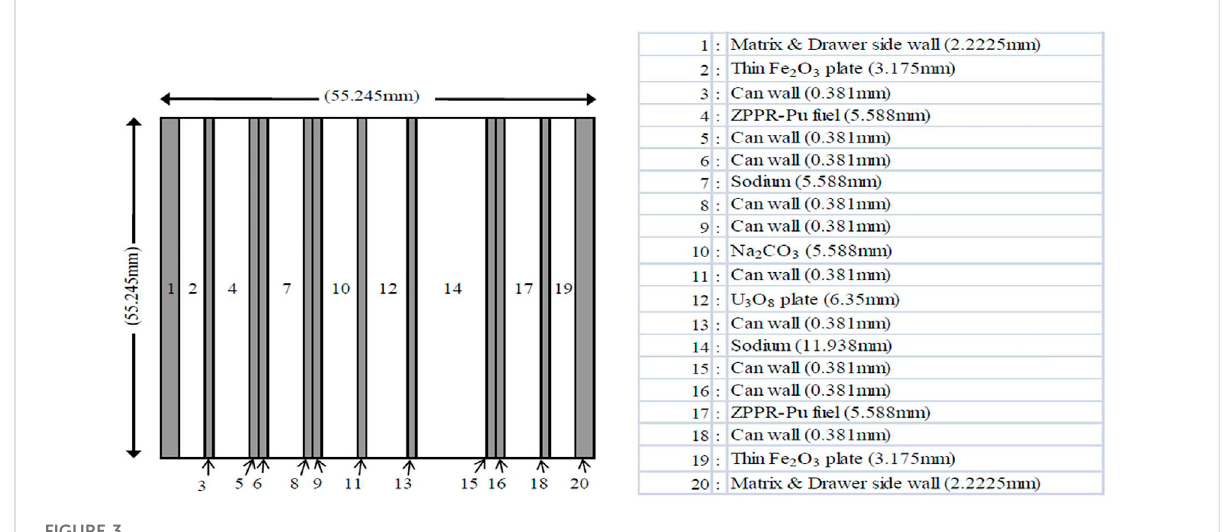
FIGURE 3 Geometry and layout of the ZPPR-10B